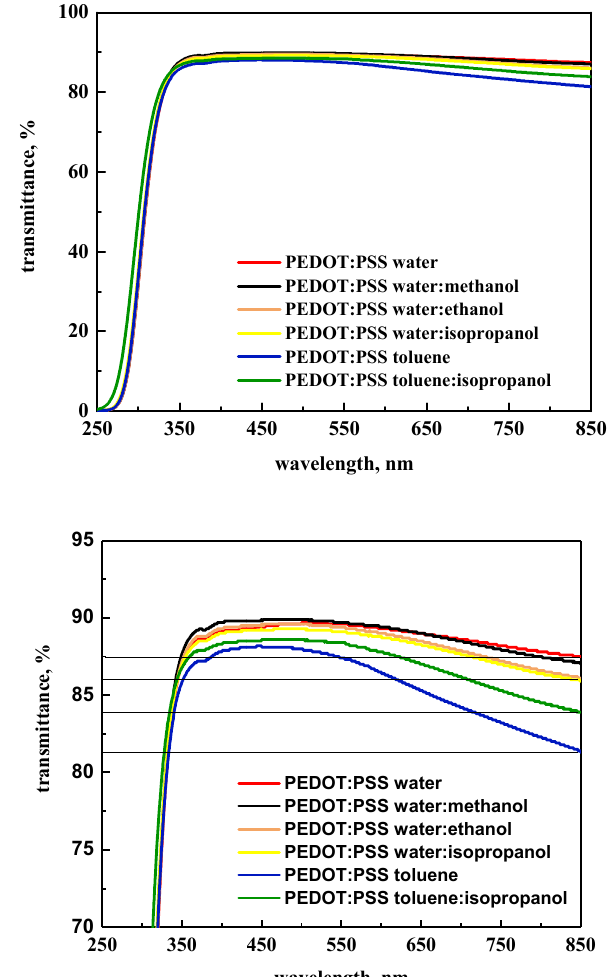
Figure 7. UV–Vis spectra of PEDOT:PSS layers in full (top) and from 70% to 95% (bottom) transition mode.